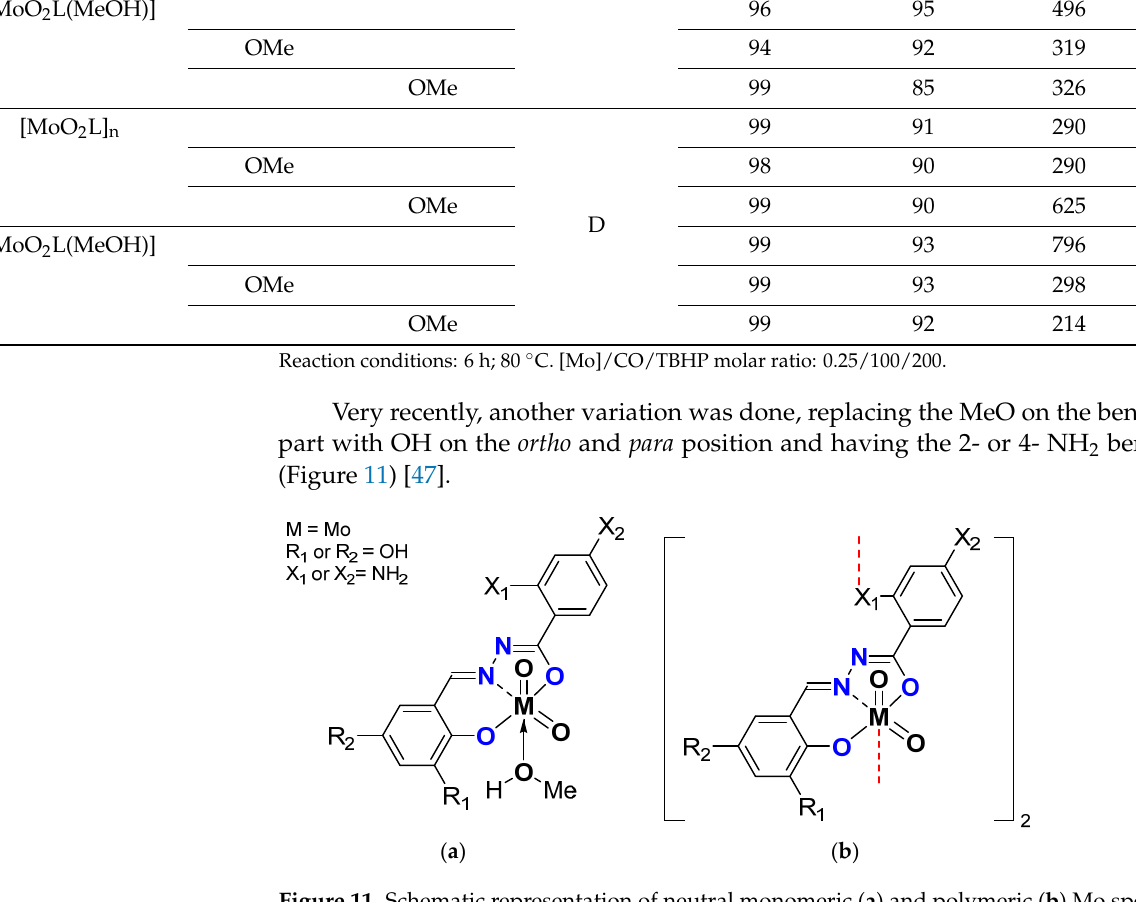
Figure 11. Schematic representation of neutral monomeric ( a ) and polymeric ( b ) Mo species studied containing the salicylaldehydato fragment in the hydrazonato ligand. containing the salicylaldehydato fragment in the hydrazonato